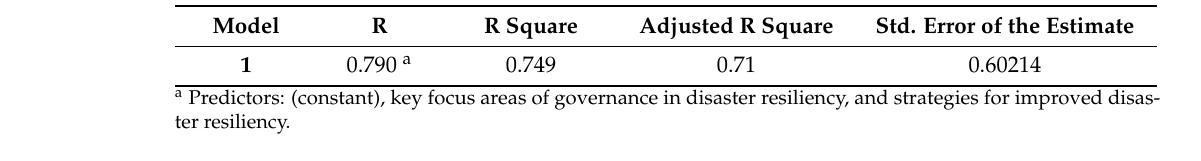
Table 6. Model summary.